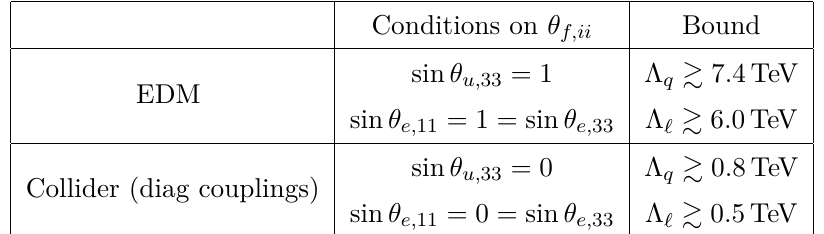
Table 9 . Summary of the bounds on Λ q,‘ due to EDMs and collider Higgs boson production data. In the second column, the corresponding conditions on the phases θ f,ii are also